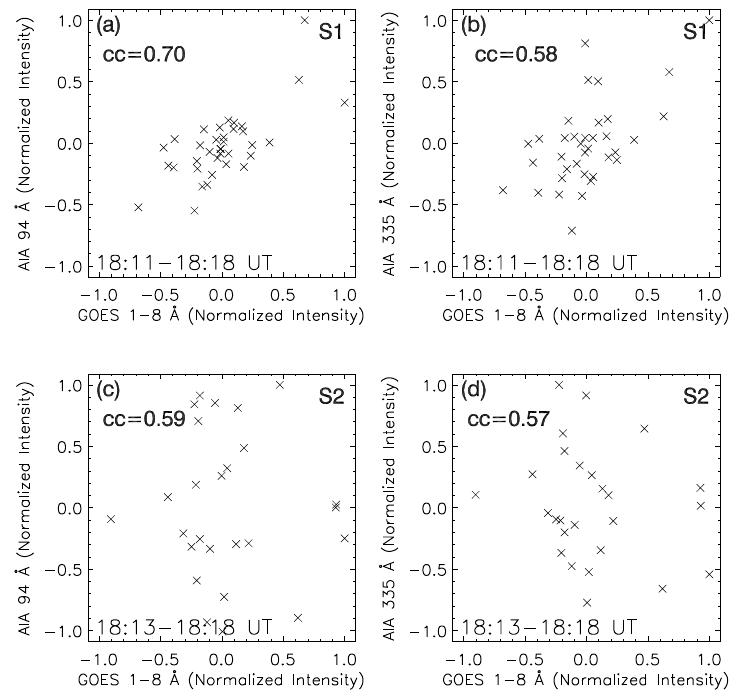
Figure 10. Correlation between the fast-varying components of GOES 1–8 ˚A and of AIA 94 ˚A at S1 (panel a ) and S2 (panel c ) or of AIA 335 ˚A at S1 (panel b ) and S2 (panel d ). The correlation coefficients (cc) are